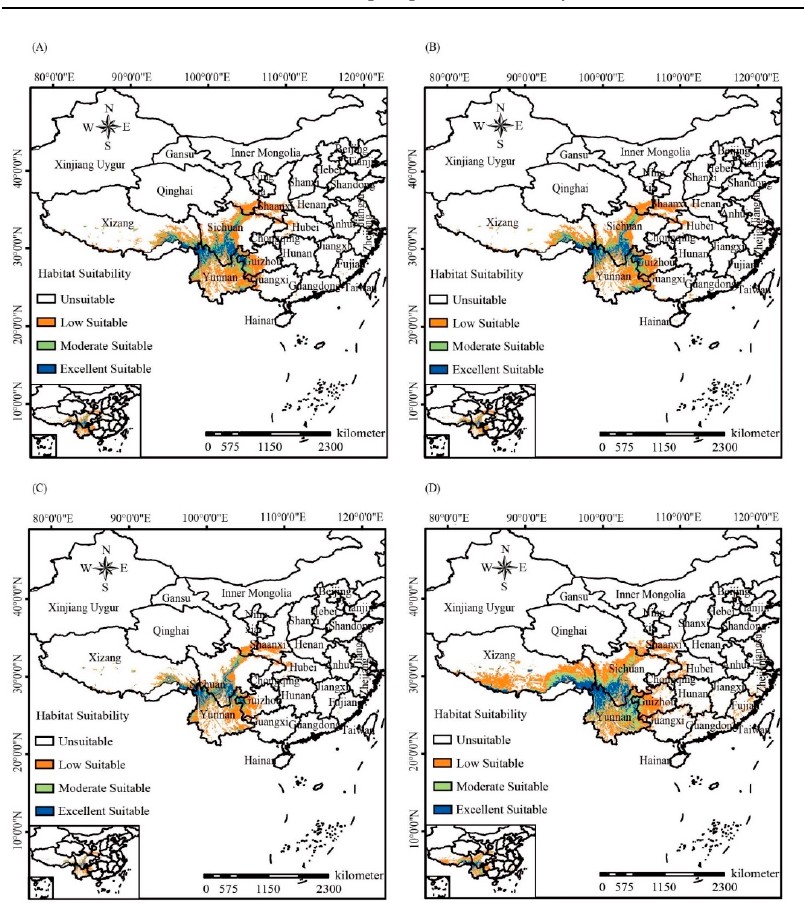
Figure 4. The distributions of suitable habitat of Gaultheria nummularioides of different time periods with MaxEnt ecological niche modeling based on mean diurnal range, isothermality, minimum tem- perature of the coldest month, temperature annual range, precipitation of wettest month, precipita- tion of driest month, and coefficient of variation of precipitation seasonality. ( A – D ) represent the Last Interglacial, Last Glacial Maximum, Current, and 2070s, respectively.